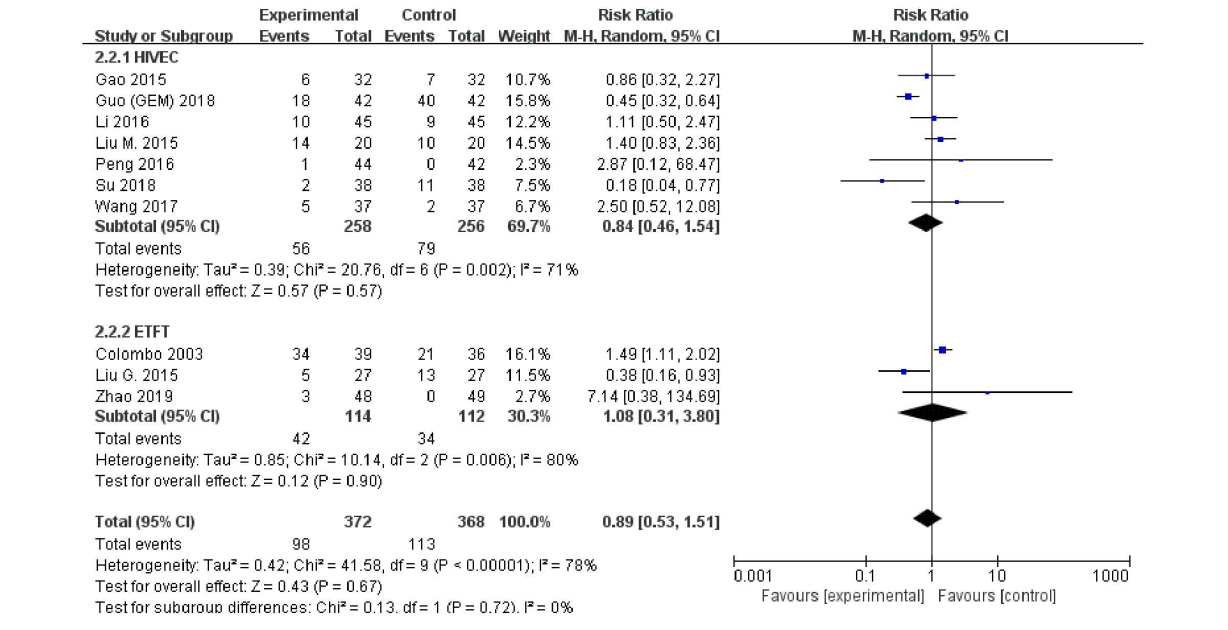
patients. The meta-analysis aimed to figure out whether